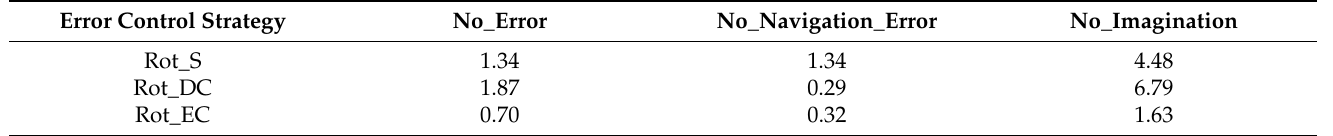
Table 3. Overview of online rotation accuracy using different error-control